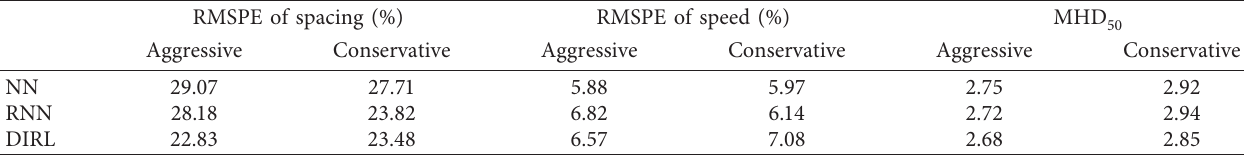
Table 3: The average performance of the models on the training sets.